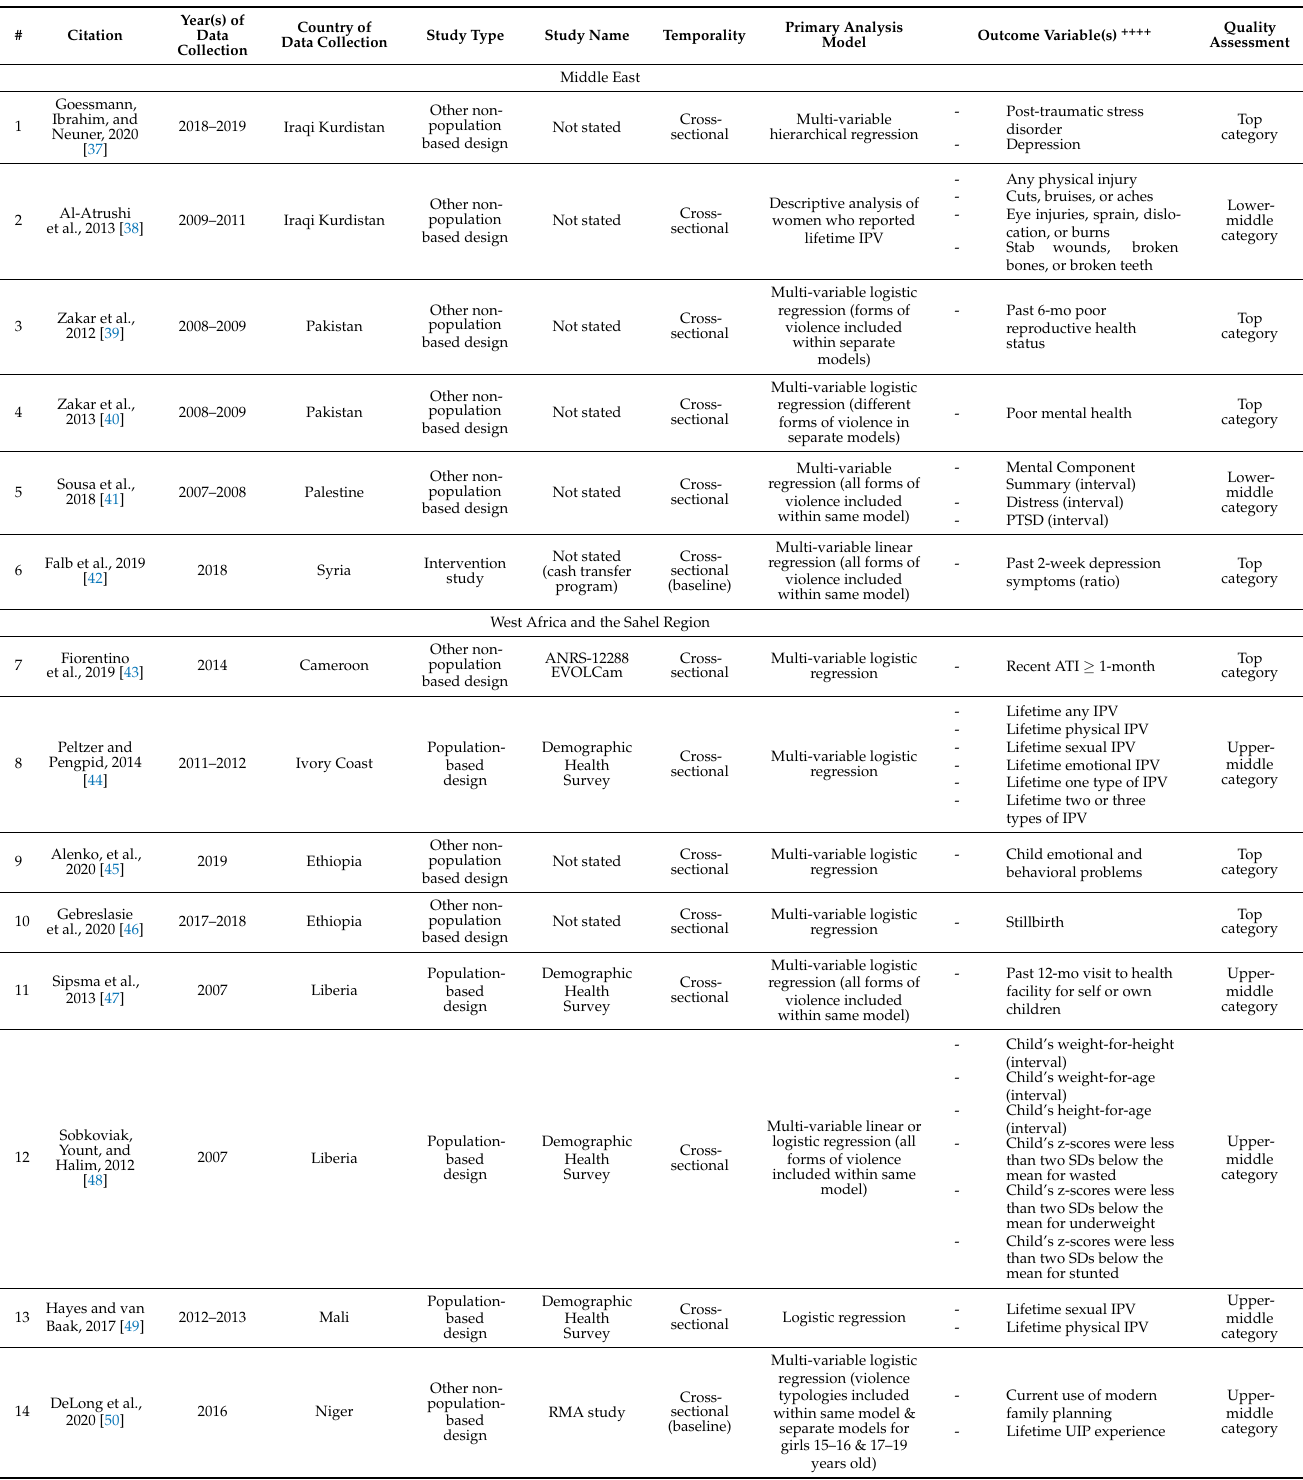
Table 1. Overview of included studies.